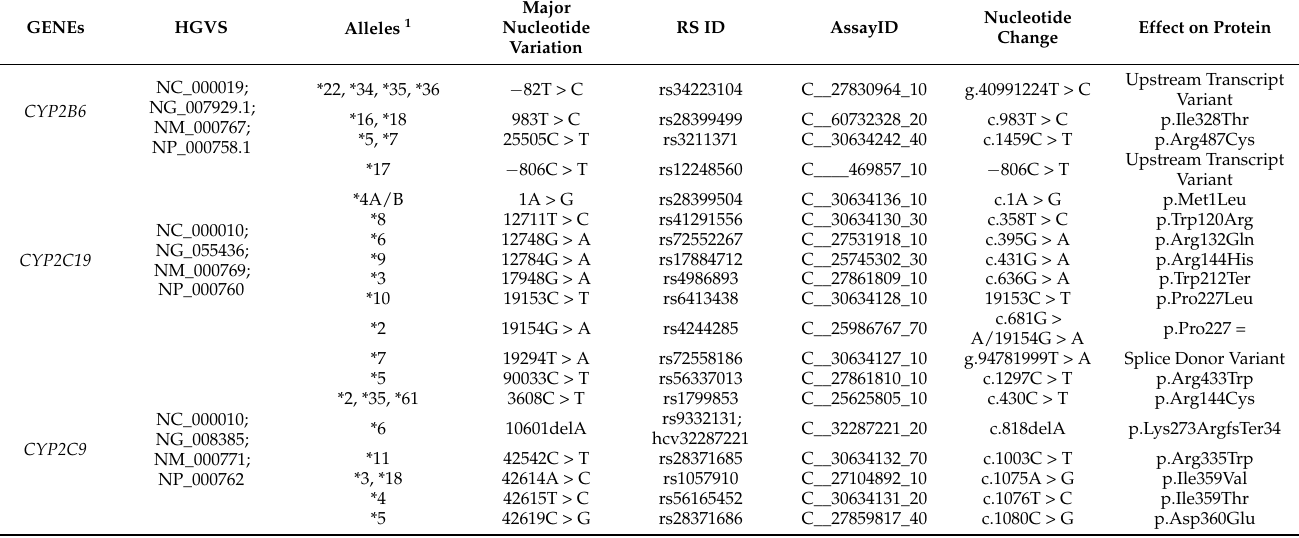
Table 1. NeuroPGx panel (based on OpenArray™